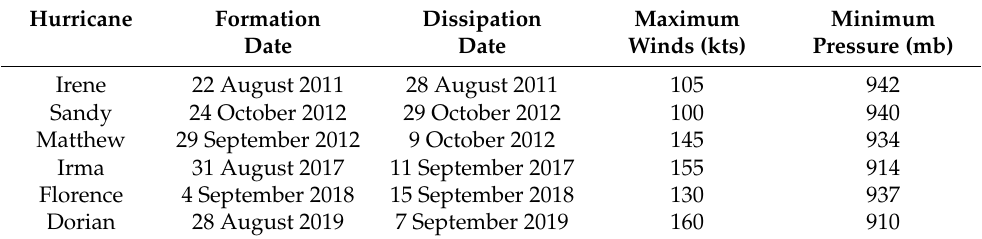
Table 1. Formation/dissipation dates, maximum winds and minimum pressures of the six hurricanes assessed in this